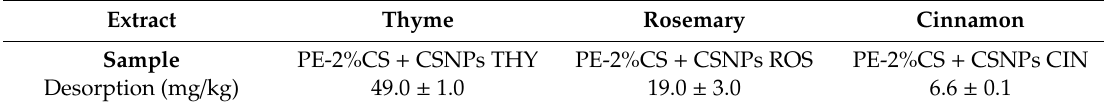
Table 4. Desorption of extracts per kg of PE foil.